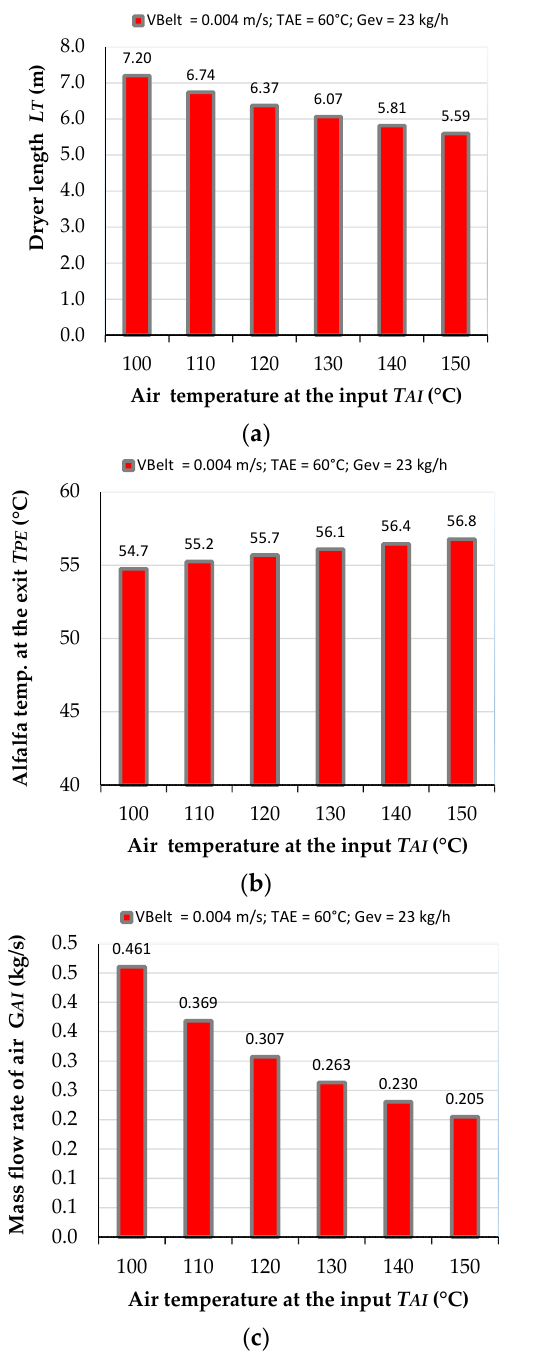
Figure 5. Simulation using the equations of the design guidelines. Left, histograms vs. air temperature at the dryer input T AI (with v Belt , T AE and G EV kept constant), of the: ( a ) dryer length L T ; ( b ) alfalfa temperature at the exit of the dryer T PE ; ( c ) mass flow rate of the drying air G AI . Right, histograms of the same variables, but vs. air temperature at the dryer exit T AE with v Belt , T AI and G EV kept constant: ( d ) dryer length L T ; ( e ) alfalfa temperature at the exit of the dryer T PE ; ( f ) mass flow rate of the air G AI .